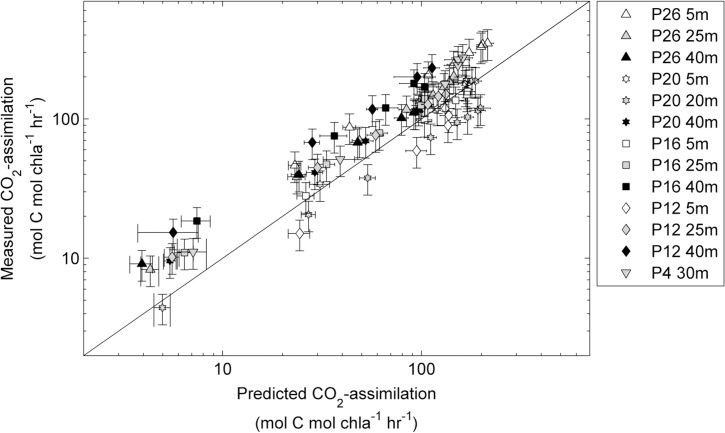
Rates of CO2-assimilation (mol C mol chl a
-1 hr-1) derived from FRRF measurements plotted against rates measured by 14C-assimilation experiments.Samples were taken at one to three depths at five stations along Line-P in the NE subarctic Pacific (see Fig 1). FRRF based PvsE curves were used to derive ETRRCII and NPQNSV at 8 light levels for each sample, and Φe:C/nPSII values were then derived from the relationship presented in Fig 7. Φe:C/nPSII and ETRRCII for each light level were used to calculate CO2-assimilation rates. Error bars for predicted CO2-assimilation rates represent the propagated error from the ChlF yields of the last three ST acquisitions of each light level during the FRRF PvsE curve used to derive NPQNSV and ETRRCII. Error bars for measured CO2-assimilation rates represent the mean coefficient of variance derived from all duplicate measurements (n = 46). The correlation between all predicted and measured data points (n = 95) was statistically significant (Spearman’s r = 0.90, two-tailed p-value < 0.0001). All statistics are for non log-transformed data.